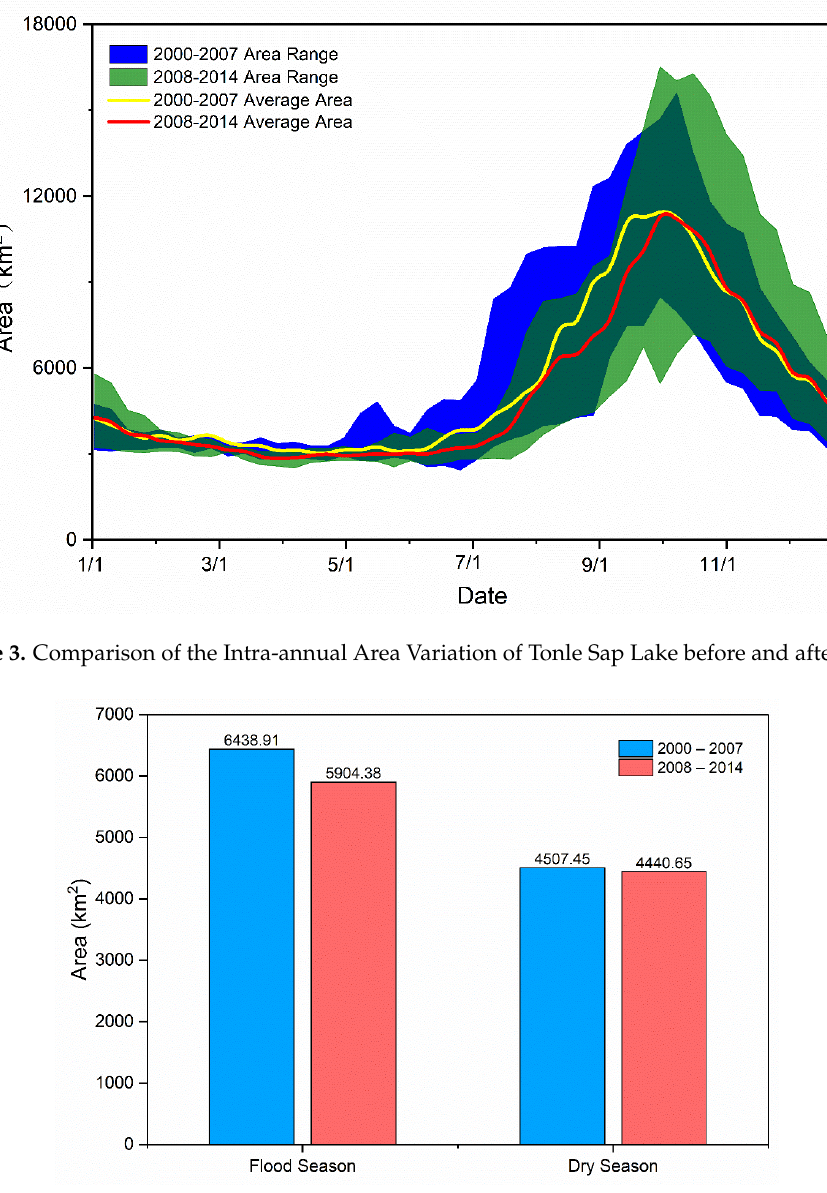
Figure 4. Comparison of the Seasonal Area of Tonle Sap Lake before and after 2008.